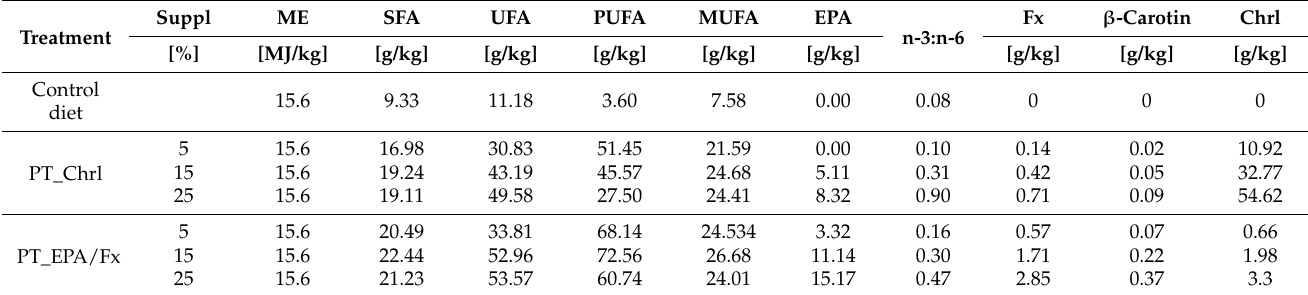
Table 1. Food composition of different